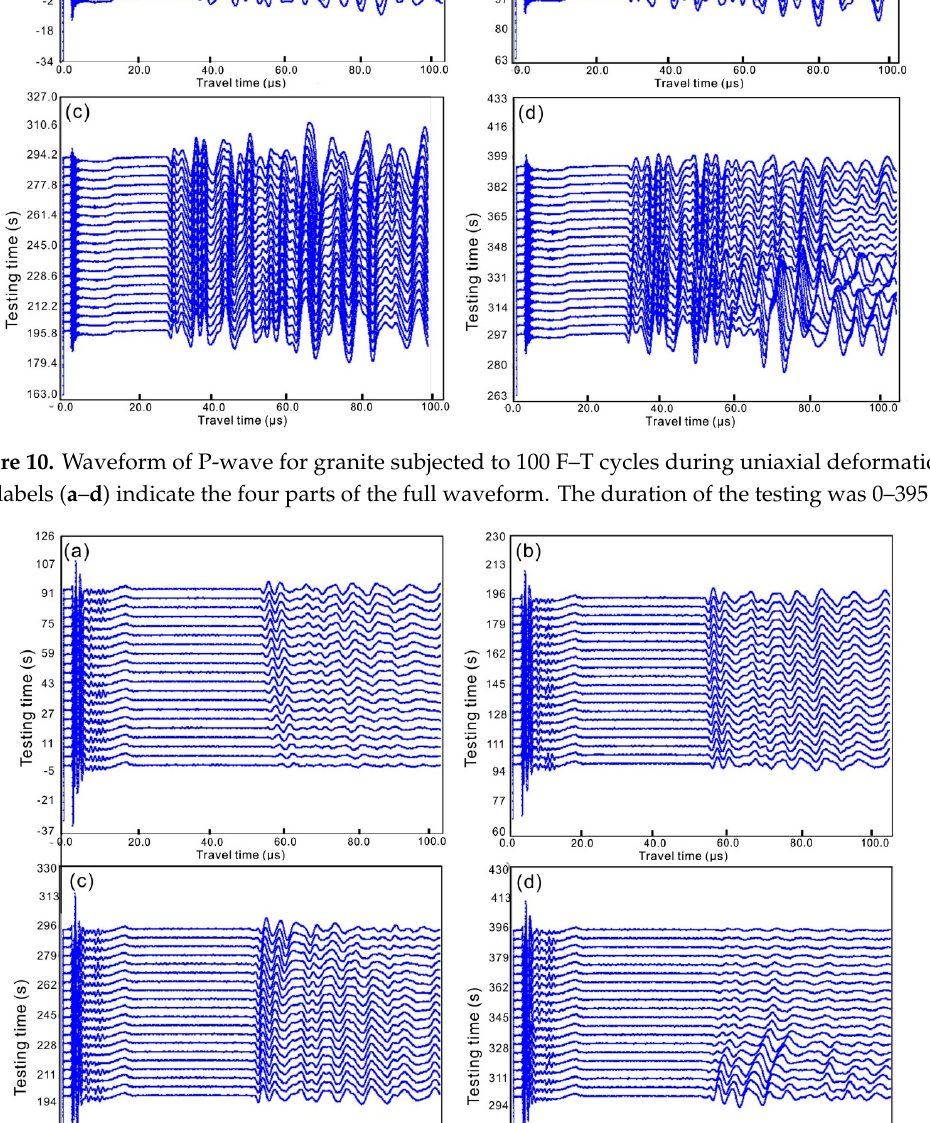
Figure 12. Determination of travel time for the P and S-waves from the waveforms. ( a ) Determination of P-wave travel time from the first wave cycle; ( b ) determination of S-wave travel time from the first wave cycle. Figure 13 plots the relationship between the P and S-velocities and axial strain, which are affected by the initial F–T fatigue damage in the samples. It can be seen that the P-wave velocity increases with sample deformation until failure for samples subjected to 0, 20 and 40 F–T cycles; however, it first increases and then decreases, and decreasing occurs after the peak stress. The changes of P-wave velocity reflect the failure mechanism of the rock samples; the results are consistent with the pattern of stress strain curves. For samples subjected to high F–T degradation, the post-peak curve gradually drops to zero, indicating that the failure blocks slide along the fracture surface. This result indicates the increase of ultrasonic travel time when the wave goes through the blocks, and the velocity decreases accordingly. The change trend of S-wave velocity shows, first, an increasing, and then, a decreasing trend. The velocity decreasing point may be related to the crack coalescence behaviors. Wang and Li [21] found that the stress at the decreasing point is roughly equal to the crack damage stress, and similar conclusions can be drawn for the